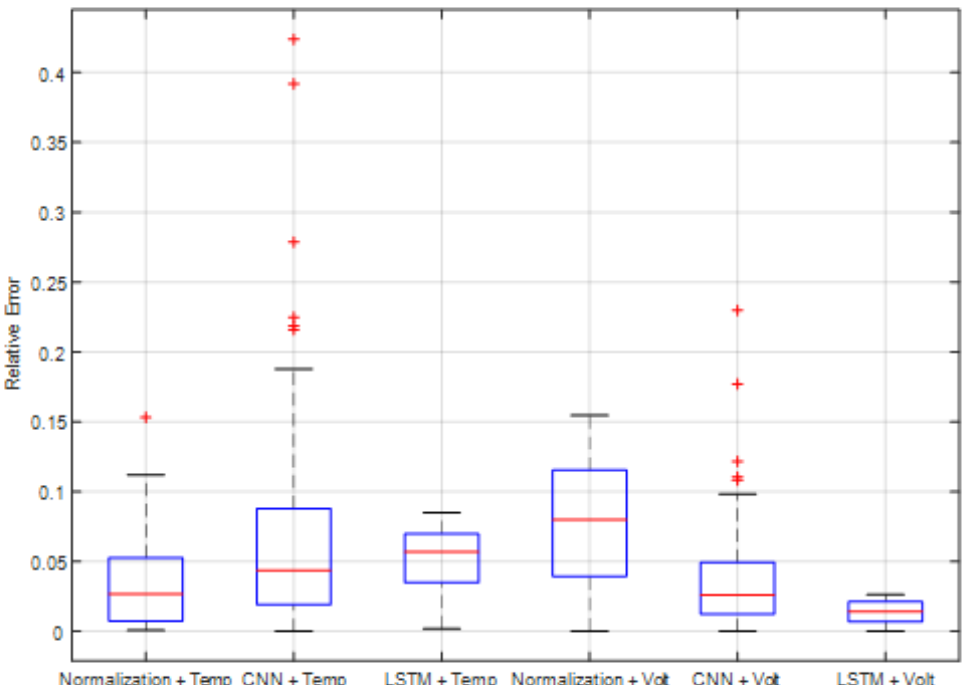
Figure 10. Relative error boxplot for each SOH estimation. Table 6. Relative error of different methods.